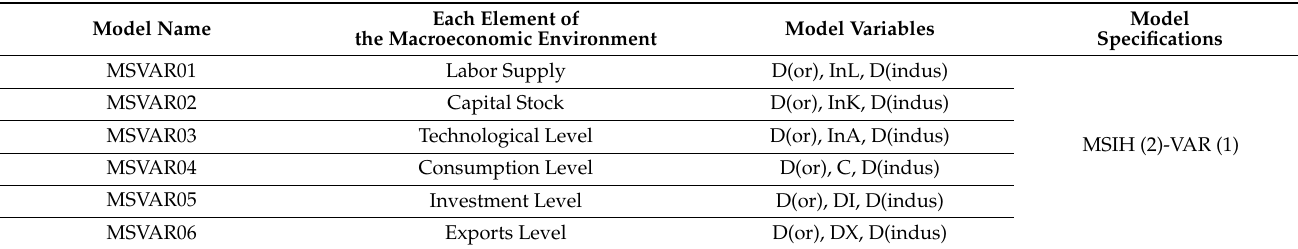
Table 2. MSVAR Model